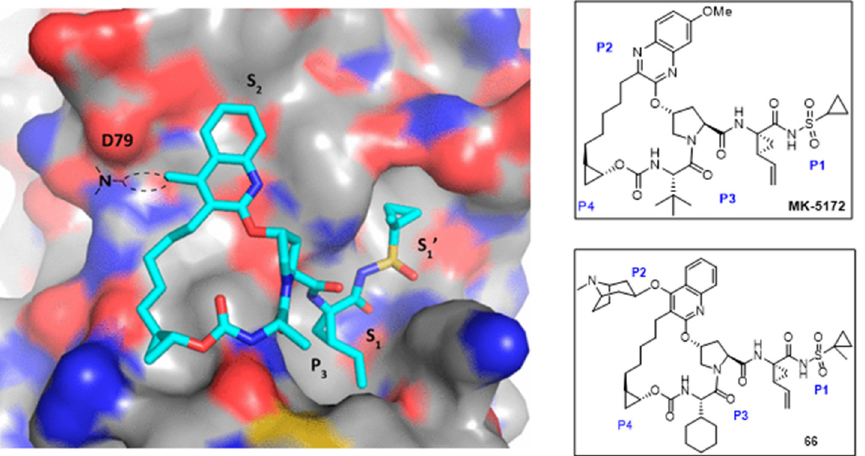
Figure 15. Visualization of 66 in the HCV NS3 gt-1b protease active site for interaction with subsites [56].